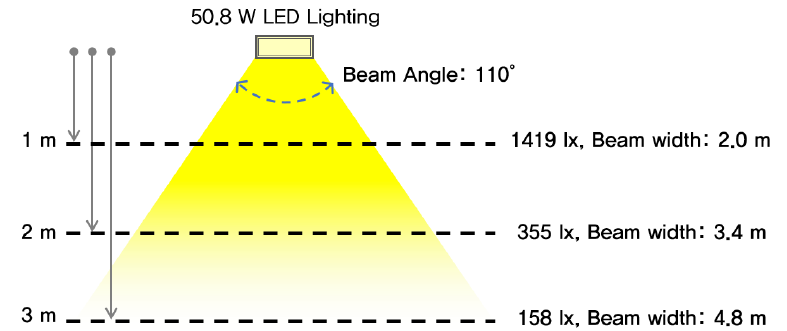
Figure 8. Test bed: section and plane. Energies 2019 , 12 , x FOR PEER REVIEW